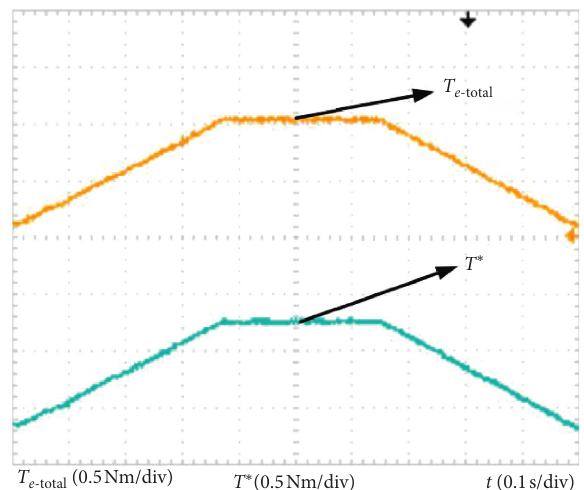
Figure 9: The tracking effect curve.